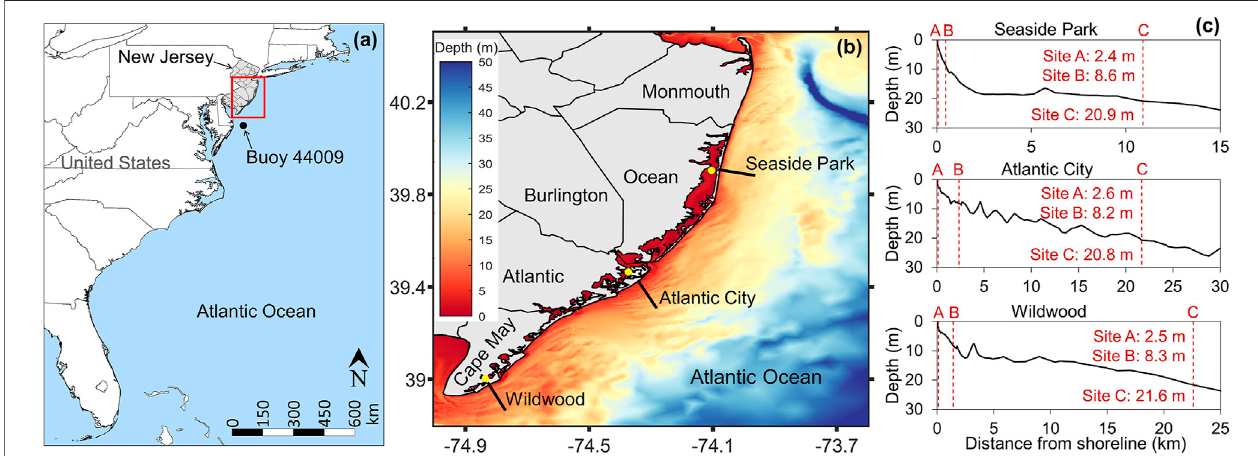
FIGURE1|(A) GeographiclocationoftheStateofNewJerseyintheNortheasternUnitedStates. (B) BathymetryincoastalwatersofthestudyareainNewJersey. The yellow circles show the location of three virtual sites in the back-bays. The black lines represent three cross-shore pro fi les named Seaside Park (normal to the coastlineofBarnegatBayIsland,OceanCounty),AtlanticCity(AbseconIsland,AtlanticCounty),andWildwood(FiveMileBeachIsland,CapeMay). (C) Bathymetryalong the three cross-shore pro fi les. Numbers represent the water depth at the location of virtual sites A, B, and C along the pro fi les.